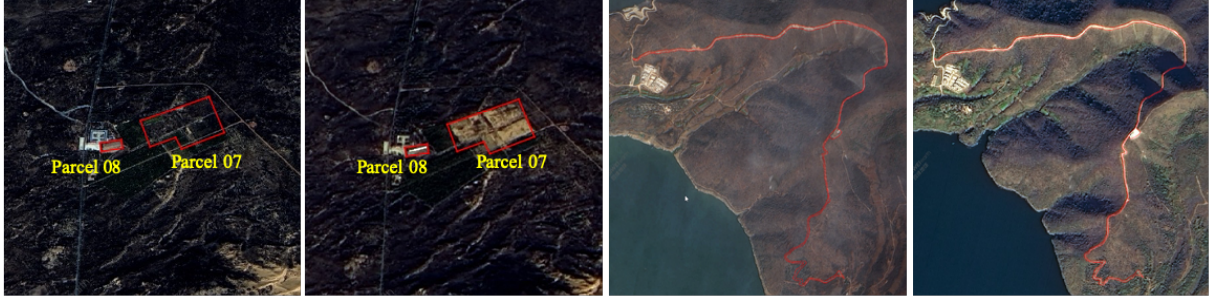
Figure 6. Parcel 07 and 08 in Haba Lake Nature Reserve Figure 7. Parcel 09 in Danjiang Wetland Nature